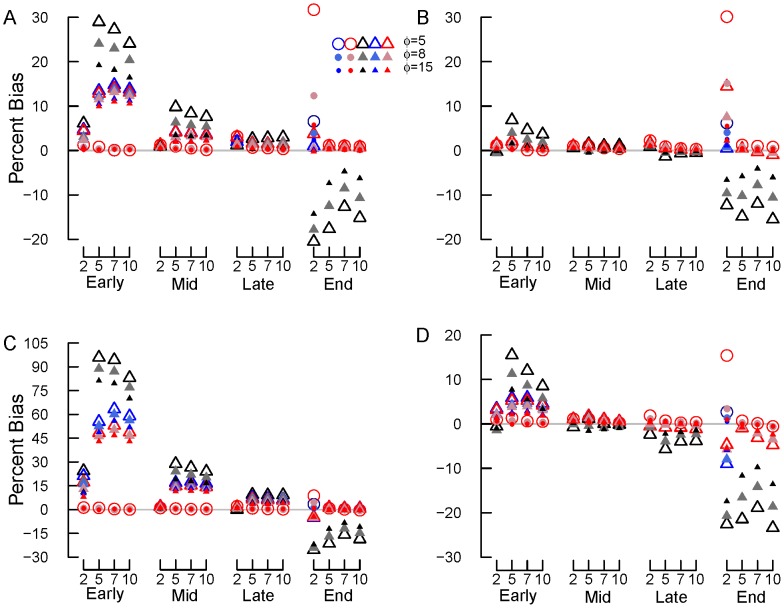
Percent bias for beta-distributed errors plus normal errors.(A) standard deviation (σ) = 0.0125 (option 3a) and SV transformation, (B) σ = 0.0125 (option 3a) and REP transformation, (C) σ = 0.05 (option 3b) and SV transformation, (D) σ = 0.05 (option 3b) and REP transformation. Early, mid, late and end are early, mid, late and end stage decomposition simulations. The numbers 2, 5, 7 and 10 are the numbers of measurements used in each simulation. Blue circles = NLS, Red circles = Normal ML, gray/black circles = Beta ML. In most cases, nls = Normal ML so that the red circles cover the blue circles. Gray lines show 0% bias.